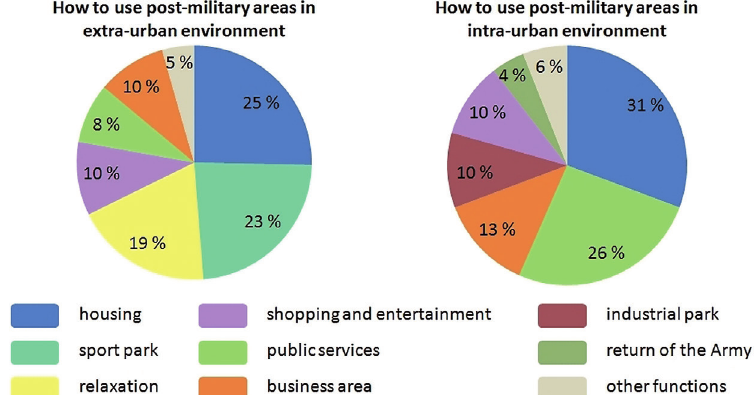
Fig. 6. Partial results of the research on how to use post-military areas in extra- and intra-urban environments Source: authors’ own research